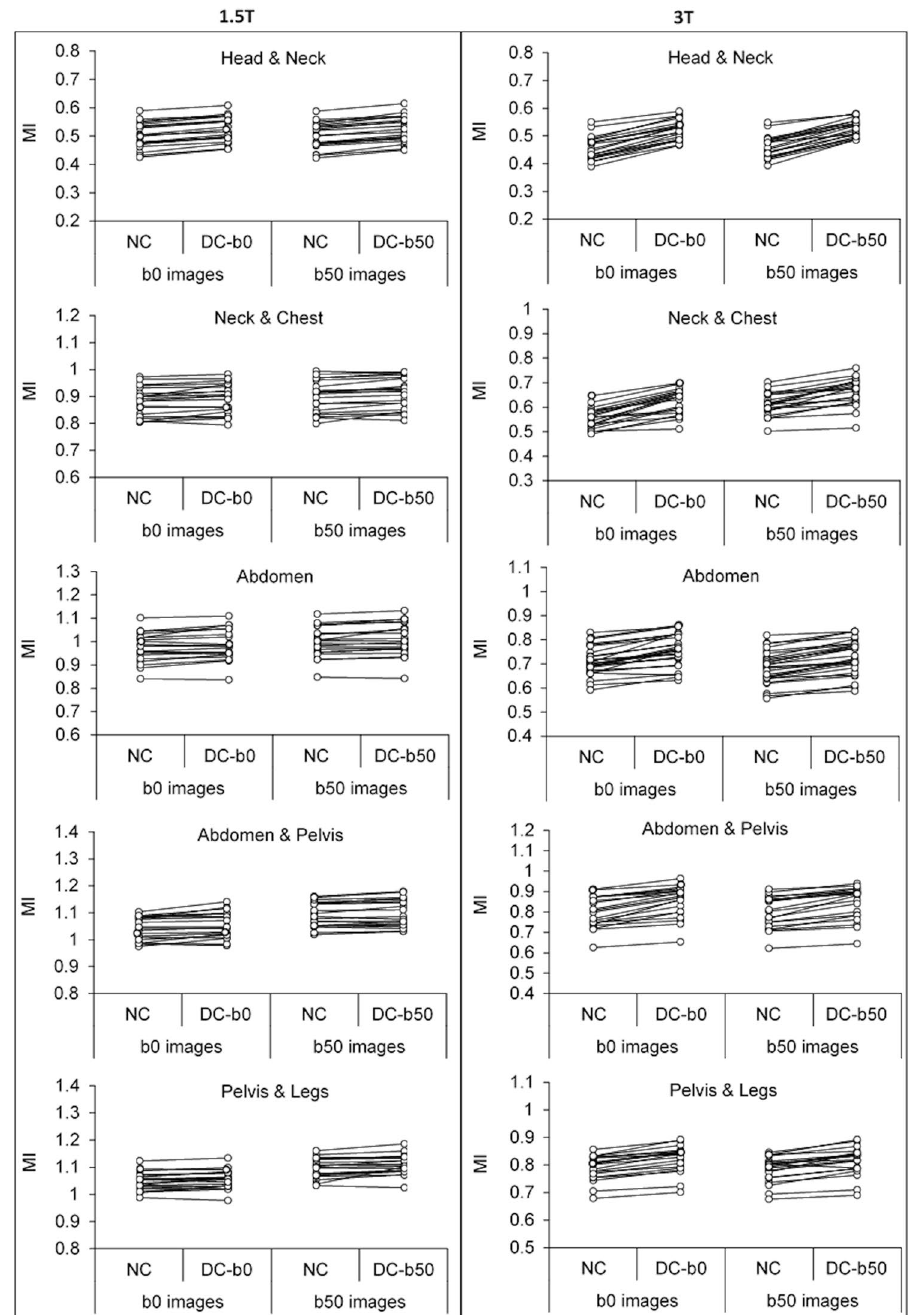
Figure 3. Mutual Information (MI) measured station-wise for non-corrected (NC), b0-based distortion corrected (DC-b0) and b50-based distortion corrected (DC-b50) data at 1.5T (left) and 3T (right). For the b0-based correction MI has been calculated between b0 and structural images, while for the b50-based correction MI has been calculated between b50 and structural images. An increased MI was obtained for the distortion corrected data for all anatomical regions (Wilcoxon signed-rank test, P <